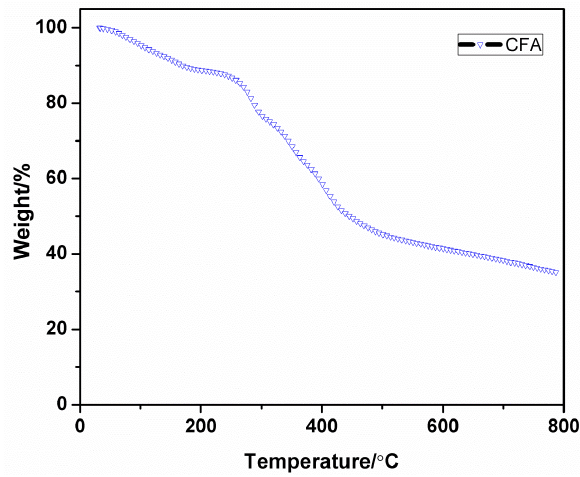
Figure 5. TGA curve of CFA.